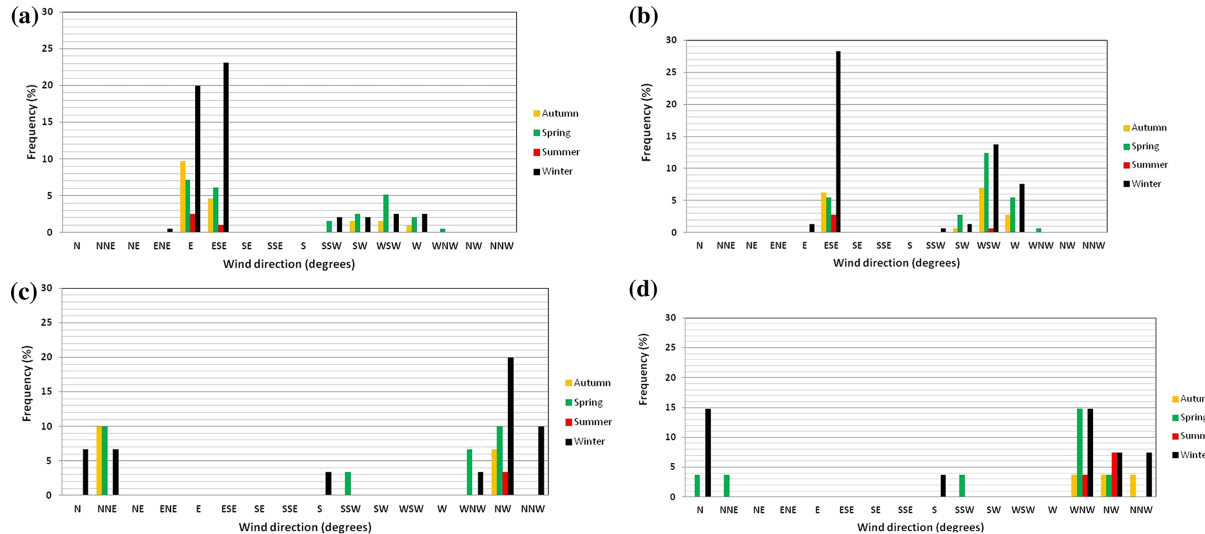
Fig. 7. Seasonal bar diagrams of the frequency of occurrence (%) of each wind direction ( a ) west and ( b ) east of Rio Strait. The minimum selected wind speed threshold throughout the period January 2007 to December 2011 is 12ms − 1 . Seasonal bar diagrams of the frequency of occurrence (%) of each wind direction ( c ) west and ( d ) east of the Isthmus of Corinthos. The minimum selected wind speed threshold throughout the period January 2007 to December 2011 is 12ms − 1